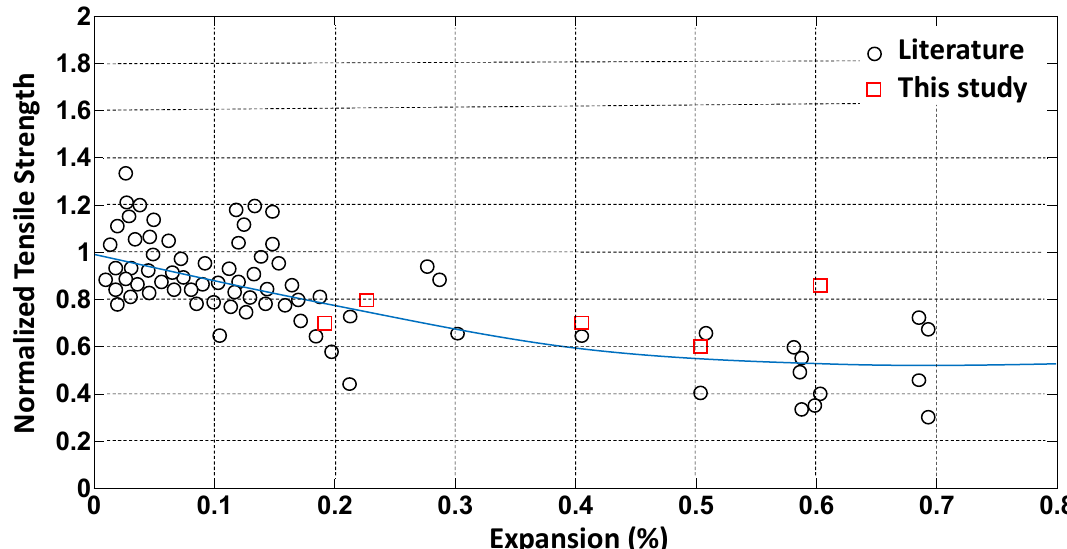
Figure 2. Normalized tensile strength versus ASR expansion.